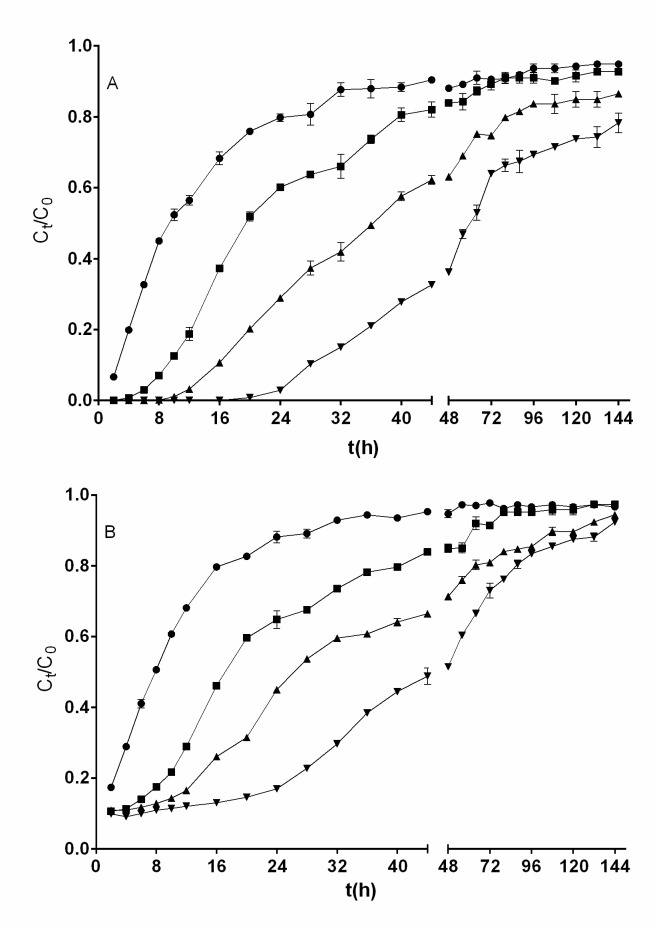
Influence of bed height on the breakthrough curve for removal of Cr(VI) (A) and total chromium (B) by QCS [bed height (cm): ●, 1.7; ■, 3.5; ▲, 5; ▼, 6.5]. Conditions: influent Cr(VI) concentration, 200 mg L−1; influent flow rate, 0.75 mL min−1; solution pH, 2.0. When they do not appear, standard deviation bars are smaller than the size of the symbols.